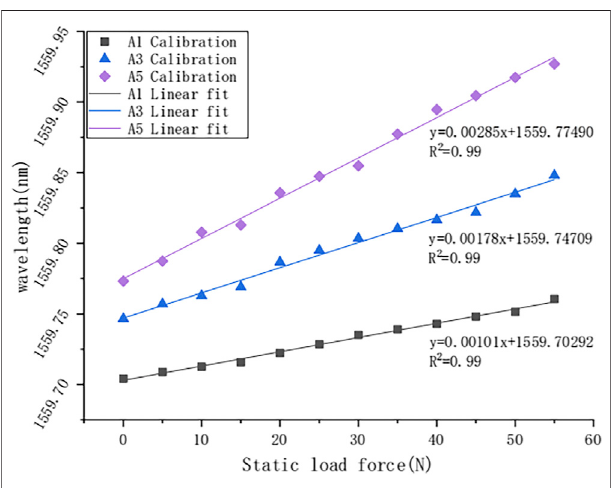
FIGURE 6 | Front-right FBG wavelength variation. considered as a constant to be calibrated at each strain measure location. The strategy used in this article was to apply force at different locations of the pantograph head gradually.